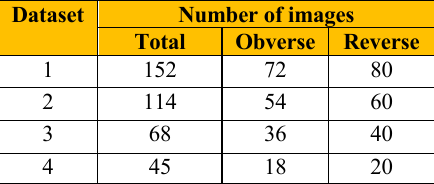
Table 4. Number of images for all datasets.